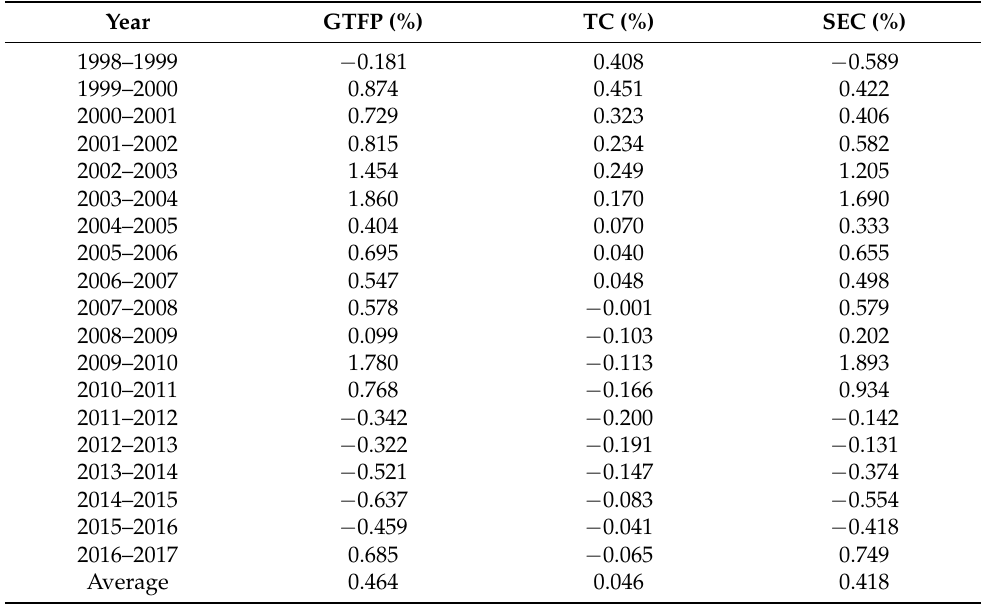
Table 7. Average GTFP growth, TC, and SC over